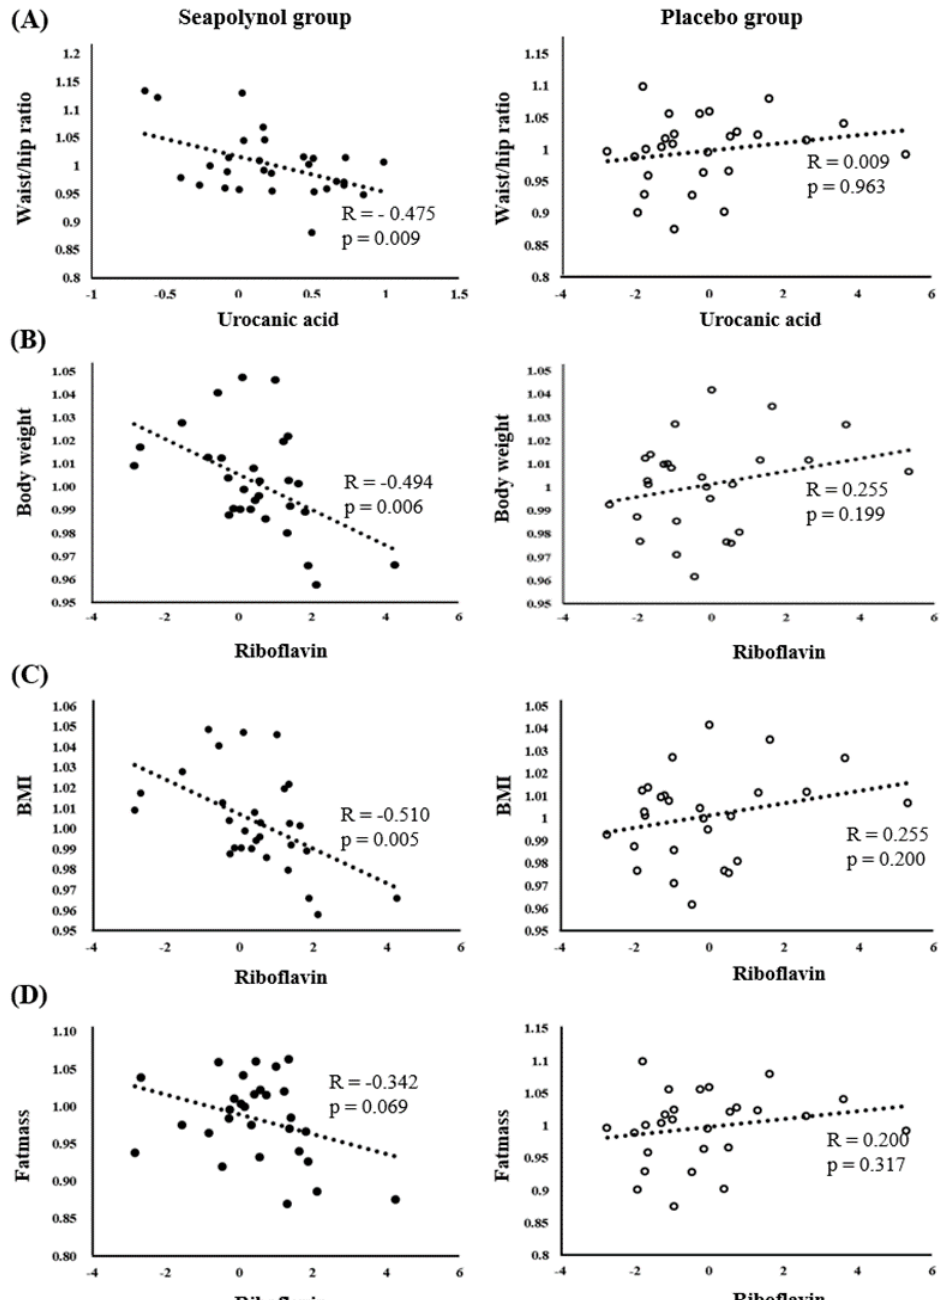
Figure 4. Relationships of riboflavin and urocanic acid with several clinical characteristics related to fat mass in the placebo and seapolynol groups. The x-axis is the log-transformed fold change (12 weeks / 0 weeks) in the metabolite level, and the y-axis represents the fold change of the clinical index in each group. Relationship between ( A ) urocanic acid and waist / hip ratio, ( B ) riboflavin and BMI, ( C ) riboflavin and body weight, and ( D ) riboflavin and fat mass. R and p represent correlation coefficient and p -value, respectively.